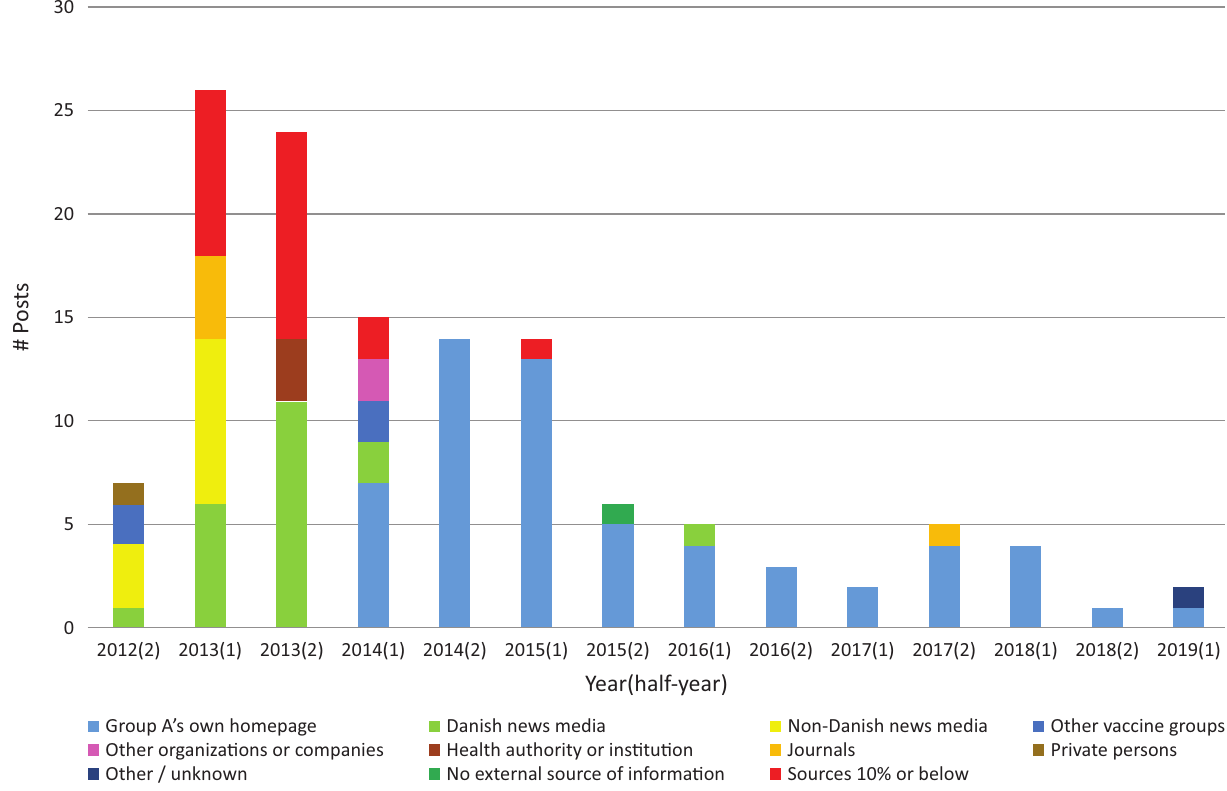
Figure 3. Sources of information on Page A until May 2019. Notes: In order to optimize data visualization, all sub-categories with relative frequencies of 10% or below have been merged into one (red section). For the same reason, we merged sub- categories ‘other’ and ‘unknown.’ The same applies to Figure 4 and